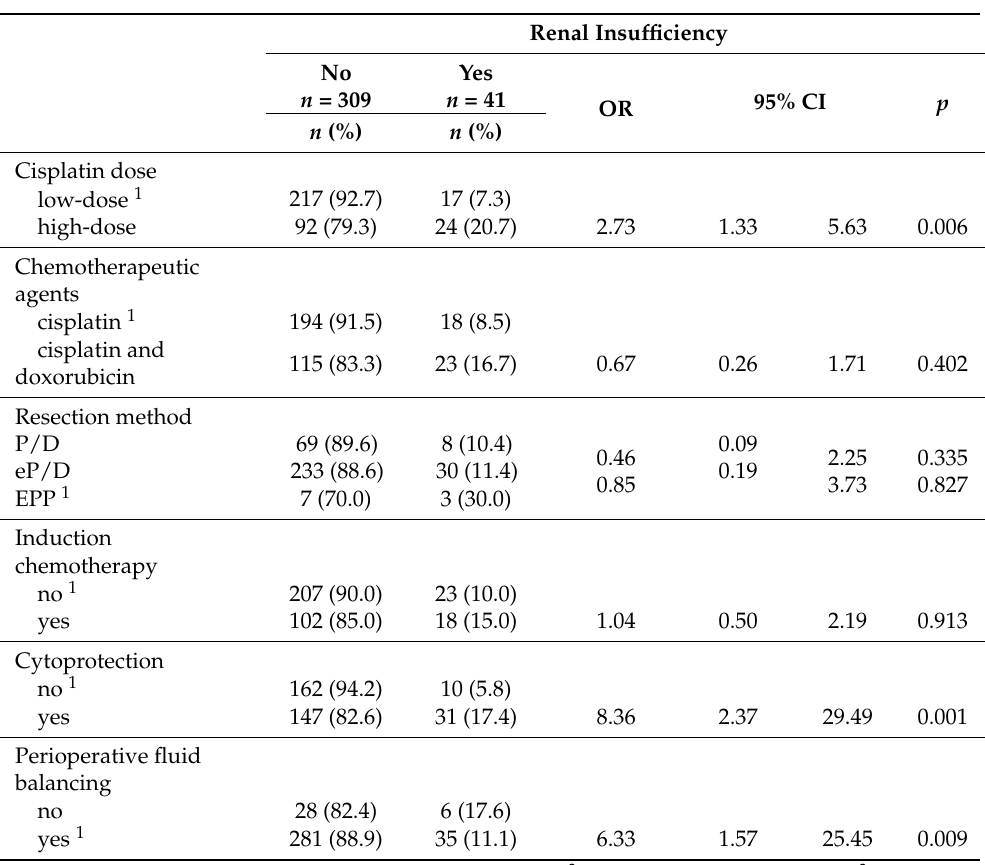
Table 5. Risk factors for renal